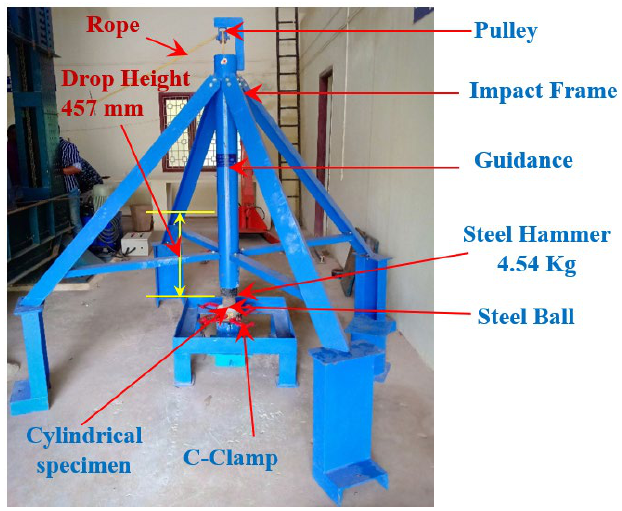
Figure 5. Impact-testing setup.